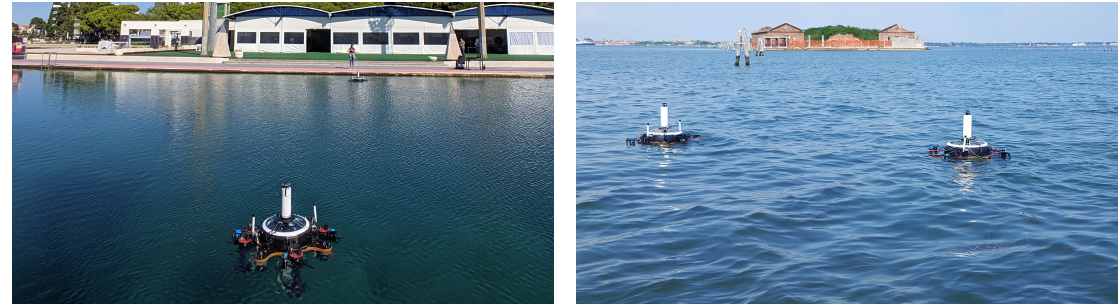
Figure 8. Experimental area in Biograd na Moru, Croatia ( left ); experimental area in the Venice Lagoon ( right